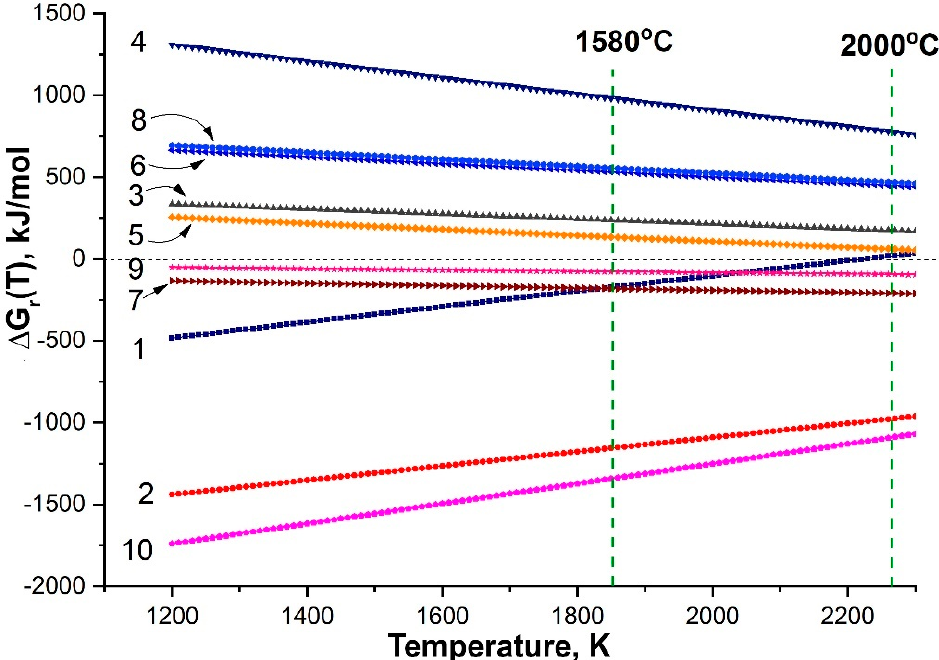
Figure 11. The temperature dependences of ∆ G r (T), calculated for reactions (1–10) in the temperature range 1200–2300 K using the IVTANTERMO software package with a built-in thermodynamic database; numbers denote reaction numbers.